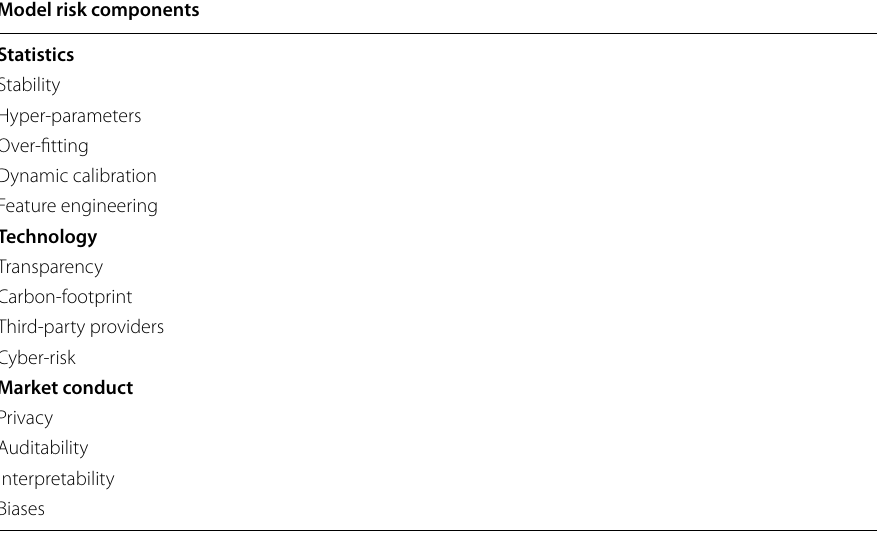
Table 1 Components of ML model